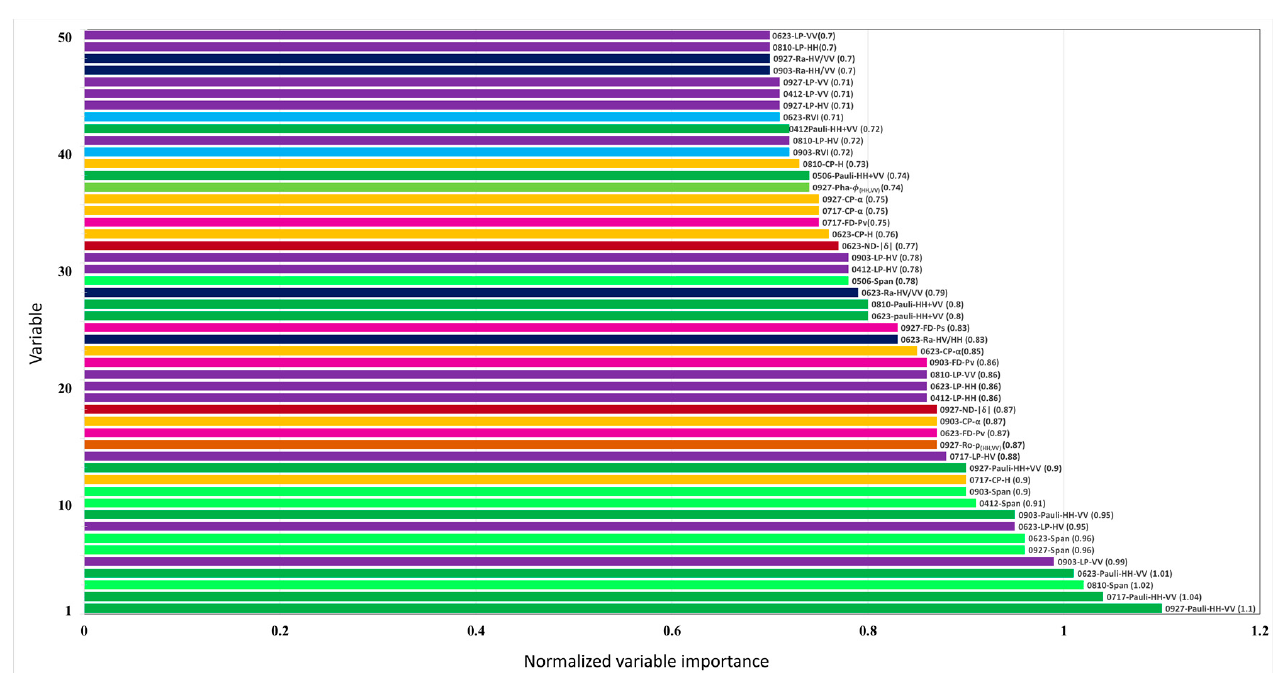
Figure 16. Normalized variable importance of RF classification with all polarimetric observables using all RADARSAT-2 images. Different types of polarimetric variables are represented as follows: LP (purple), Pauli (dark green), Span (light green), Ra (blue); Ro (orange), Pha (green), FD (pink), CP (yellow), ND (red), RVI (cyan). A variable name consists of three parts, with the prefix, center, and suffix respectively representing acquisition date, date source (see Table 1), and a certain variable (none if only one variable from data source, such as Span and RVI). For example, the first variable name 0927-Pauli-HH-VV represents the backscattering coefficient HH-VV from Pauli channel using SAR image on 27 September.